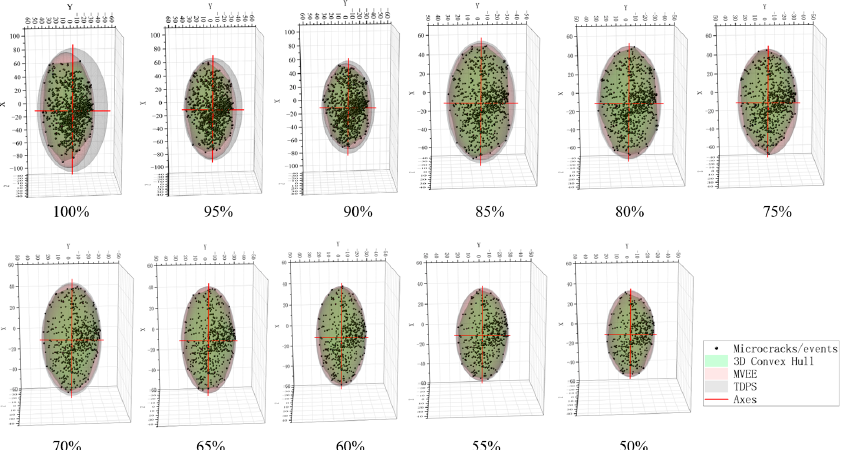
Figure 5. The spatial characterization results of specimen S3. Black dots mark the microcracks, the red ellipsoid represents the space formed by MVEE, the black ellipsoid represents the TDPS space, where the three red line segments are the three axes of TDPS, and the yellow irregular geometry is formed by 3D convex hull.